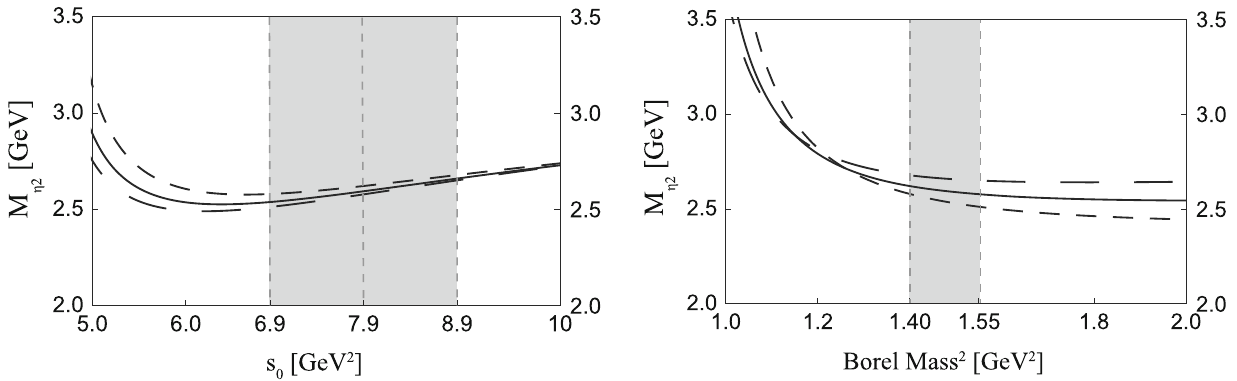
= 1 . 40 / 1 . 47 / 1 . 55 GeV 2 , respectively. In the right panel the ting M 2 B short-dashed/solid/long-dashed/dotted curves are obtained by setting s 0 = 6 . 9 / 7 . 9 / 8 . 9 GeV 2 ,